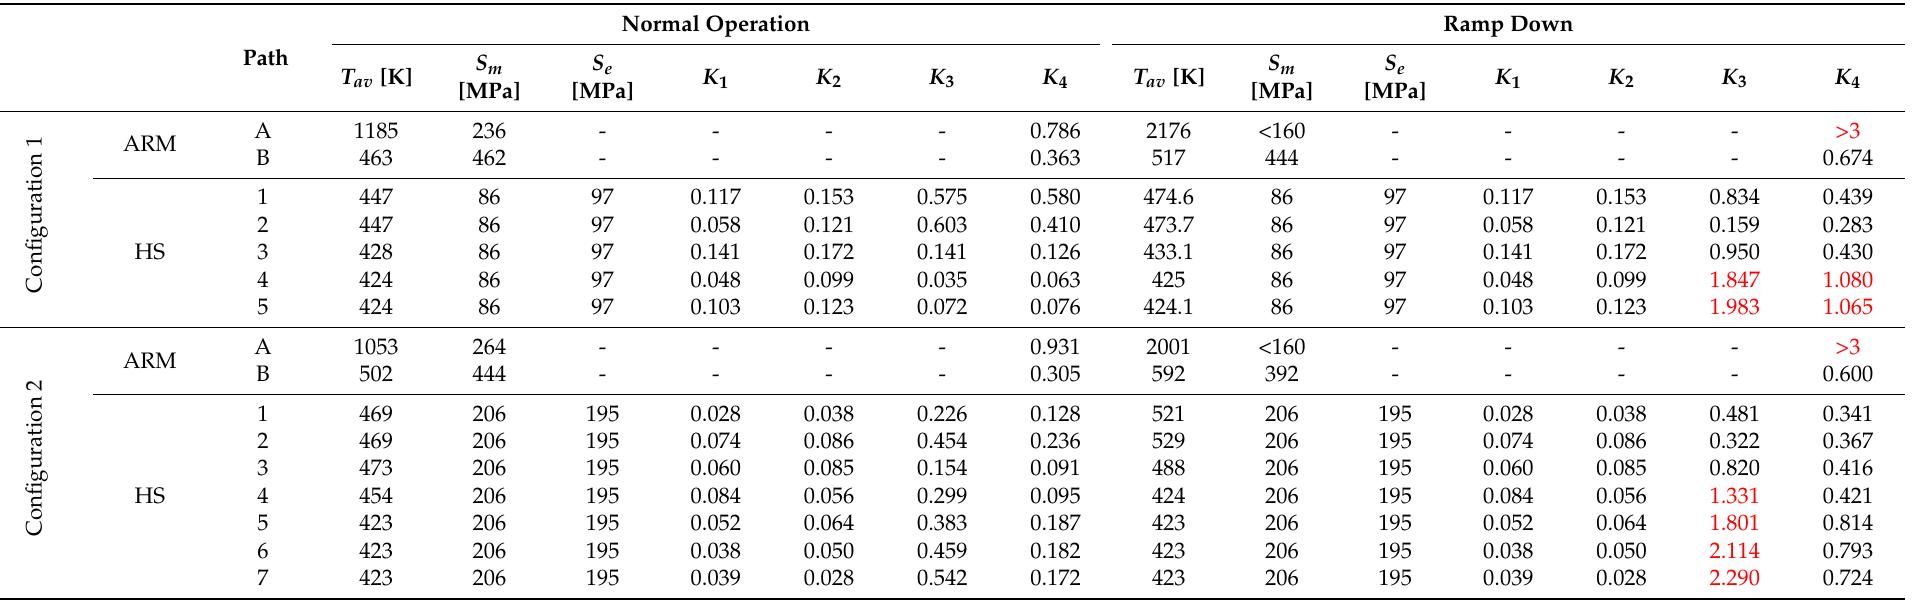
Table 4. Results of the structural verifications prescribed by SDC-IC standards . Values in red highlight the paths along which SDC-IC criteria are not met.